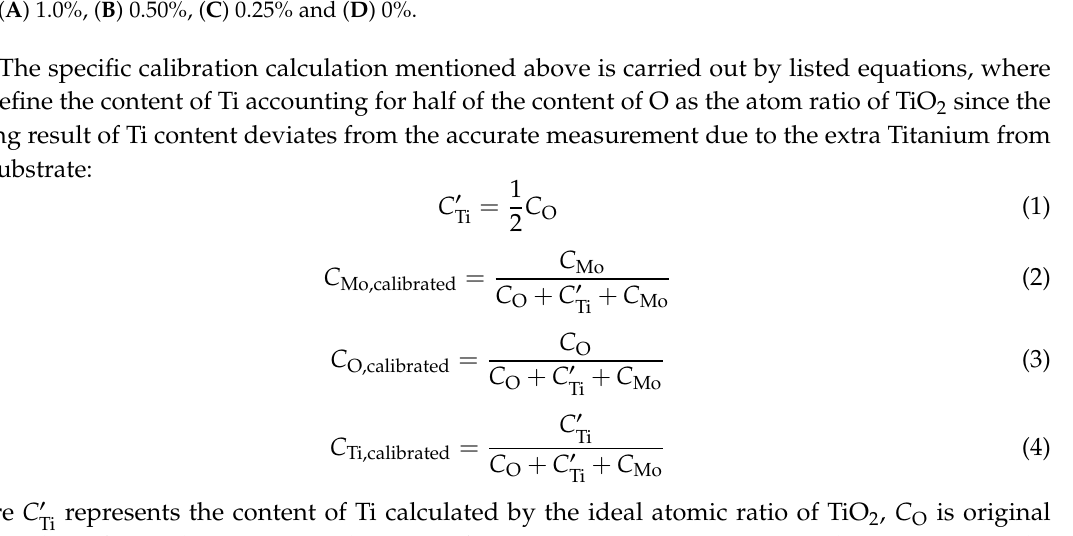
Table 1. The atomic percentages of element in various Mo-doped TiO 2 nanotube array films. Mo Sample